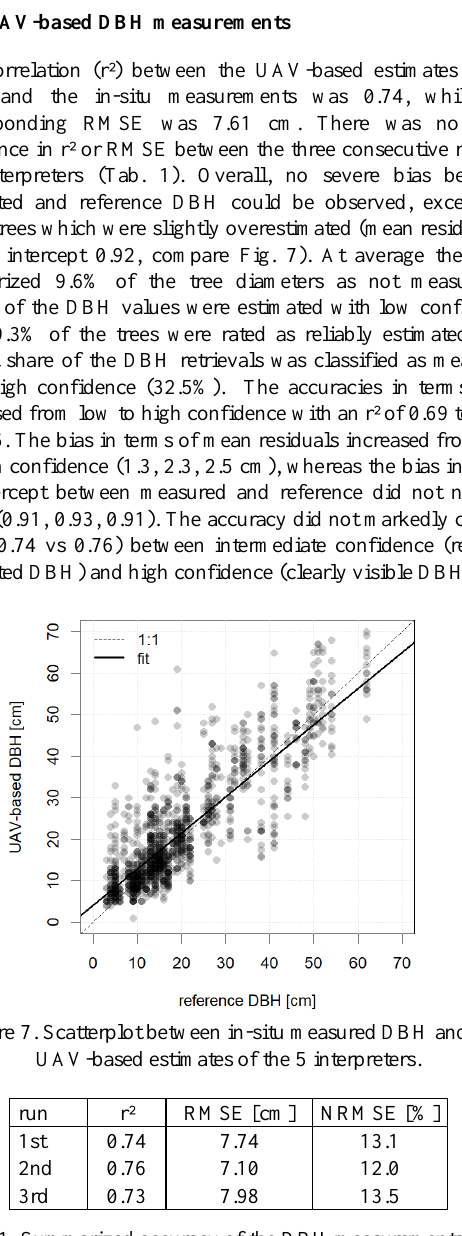
Table 1. Summarized accuracy of the DBH measurements of all